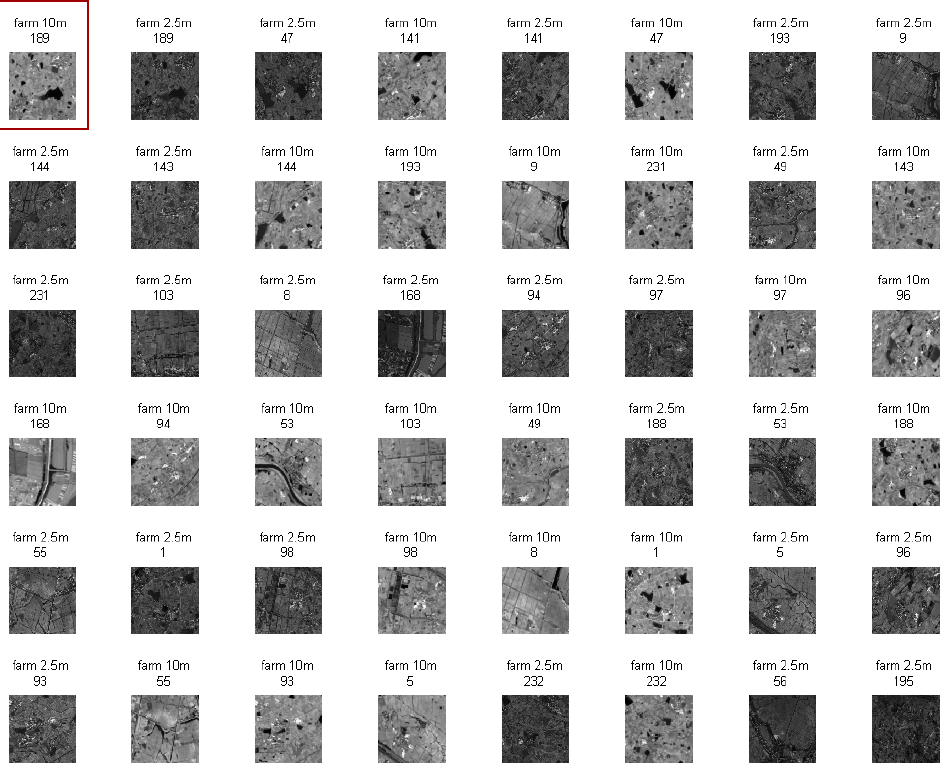
Figure 3: Retrieval results for an image patch of the Farm class. The key image patch, which is on the top left, belongs to the Farm class with 10m resolution. On the top of each image patch, the class which the image patch belongs to and its spatial resolution are shown on the first row. And the number of the image patch in the database is shown on the second